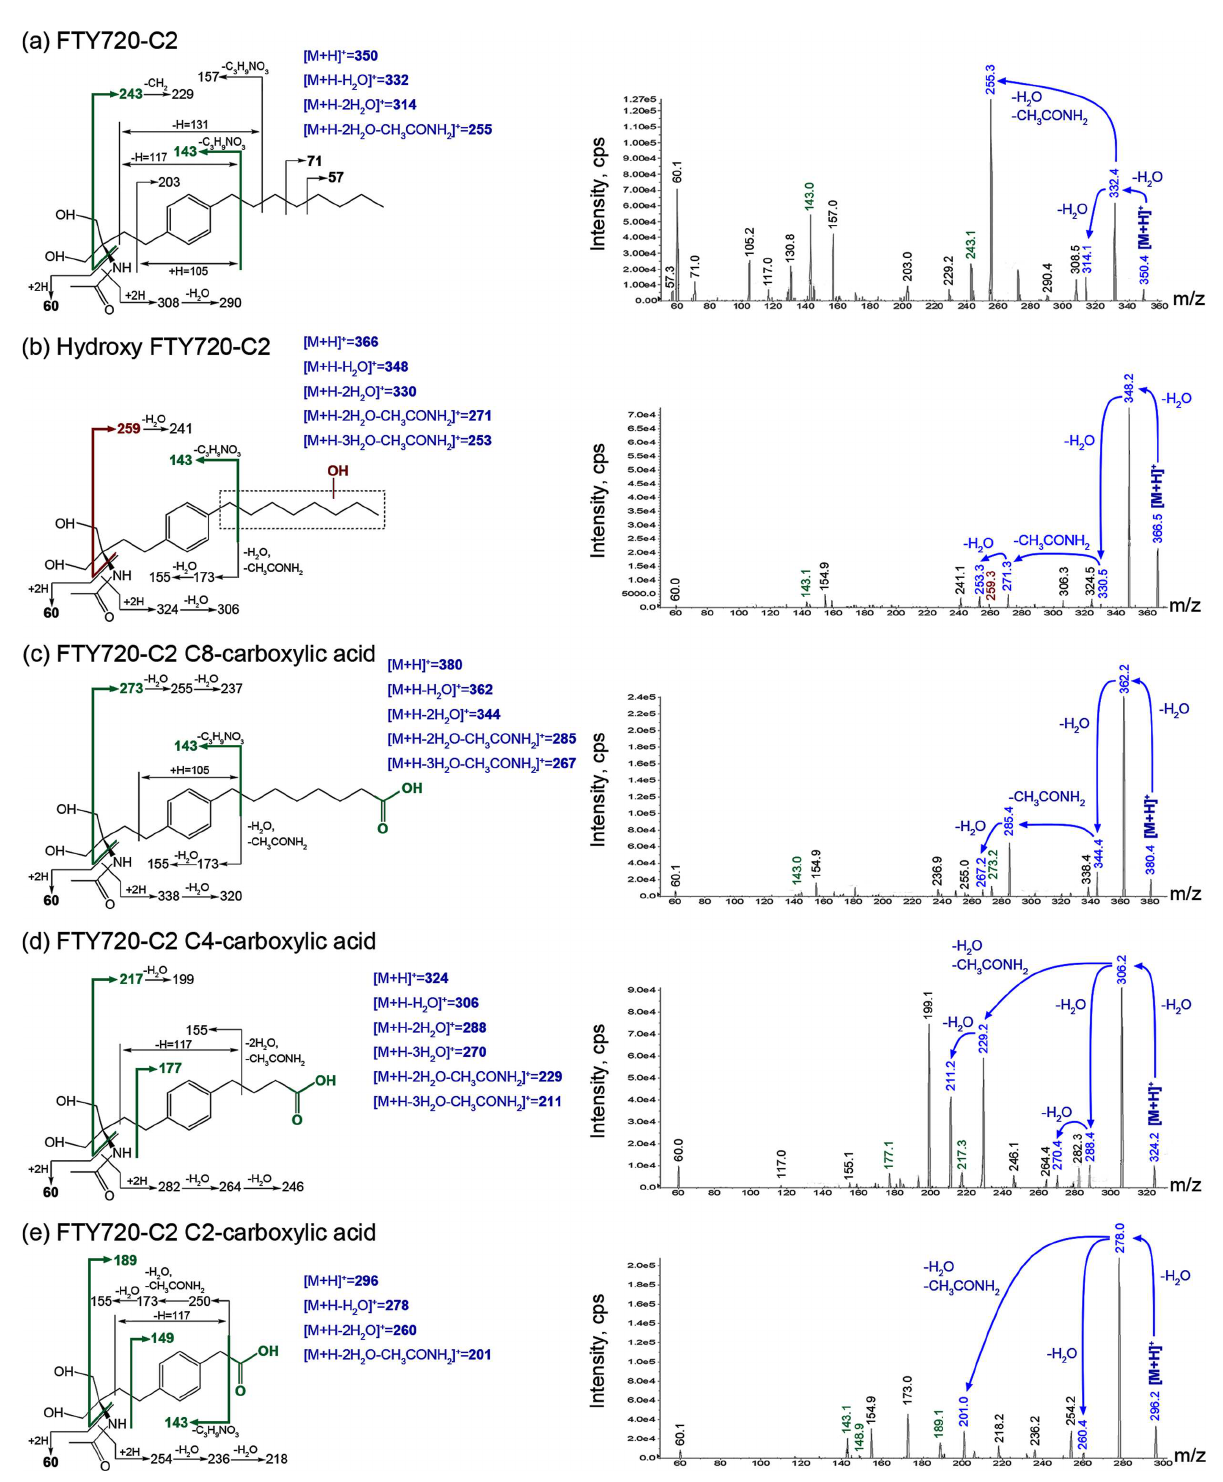
Fig 2. Proposed FragmentationSchemes and Mass Spectrafor FTY720-C2 and its Metabolites. Mass spectrometryof FTY720-C2 and its metabolites, detectedas protonatedmolecularions [M+H] + are shown. Our rationalefor identifyingthe structureof the metabolites is demonstrated using coloredtext and arrows, with blue productions indicatinglosses of H 2 O and an N -acetylgroup from[M+H] + , red productions indicatinghydroxylation, and green productions associated with identifiedcarboxylic acid modifications.